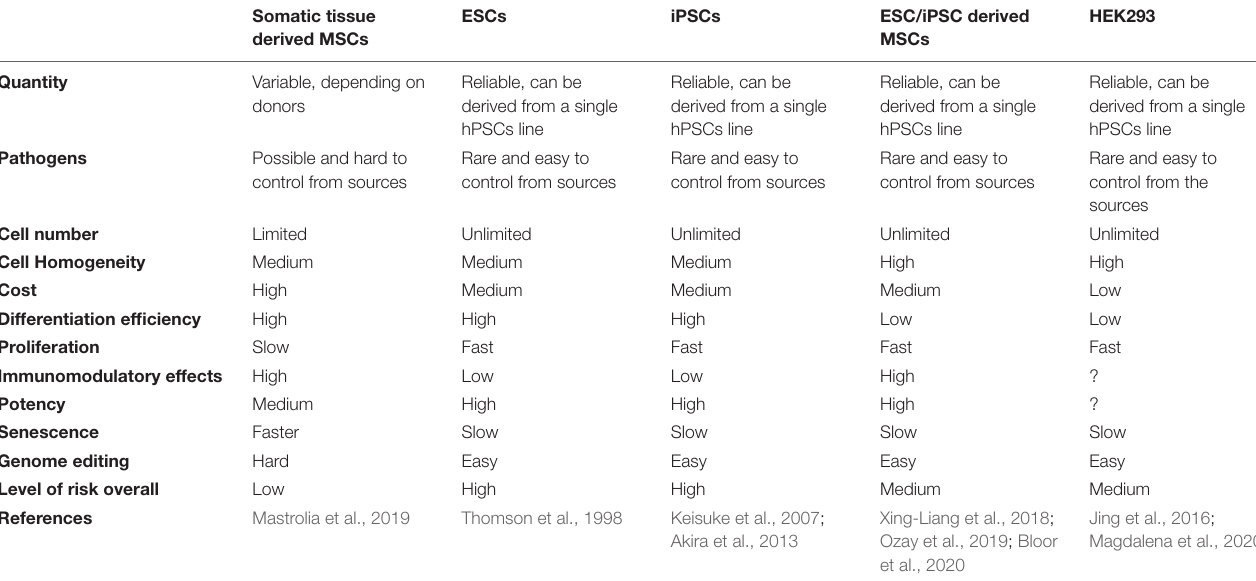
TABLE 3 | Comparison of cell sources for large scale production of